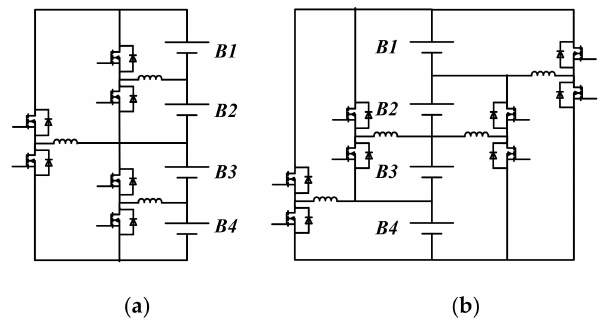
Figure 6. Circuit diagrams of the PAE and the IBLBE with 4 cells. ( a )The PAE; ( b ) the